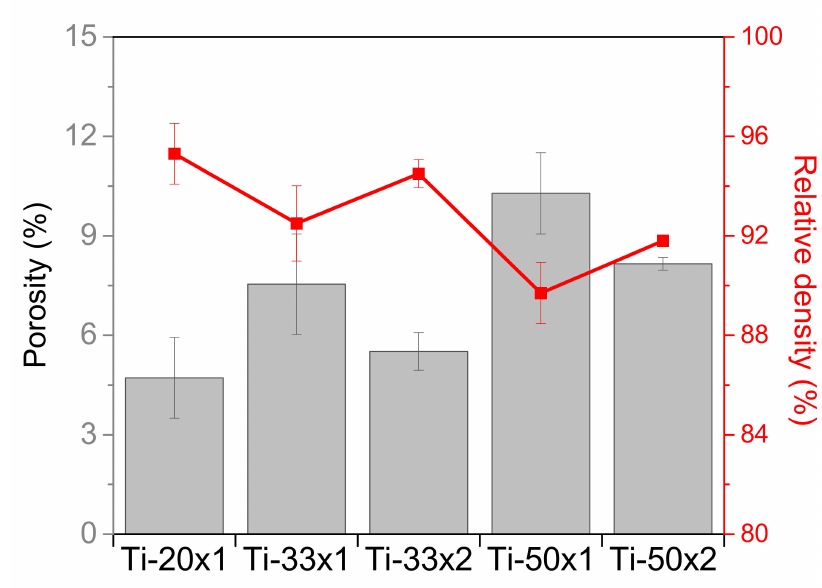
Figure 6. Porosity and relative density of the manufactured samples. Apart from this, differences were observed between the samples. Porosity in samples made by one laser scan per layer is reduced as the laser scanning speed reduces. For the conditions used, porosity was reduced by 35% by using 33 mm/s instead of 50 mm/s and reduced further by another 40% by reducing it to 20 mm/s. Therefore, the manufacturing condition with the lowest porosity was the Ti-20x1. The increase of the laser input heat from 6.0 W/mm to 9.1 W/mm raised the relative density from 89.7% to 92.5% and increasing further the heat input to 15.0 W/mm improved further the relative density to 95.3%. The application of a second laser pass of 6.0 W/mm increased the relative density to 91.8% and in the case of the use of the second pass of 9.1 W/mm increased to 94.5%. Therefore, the higher the heat input, the higher the relative density of the samples. However, an excess